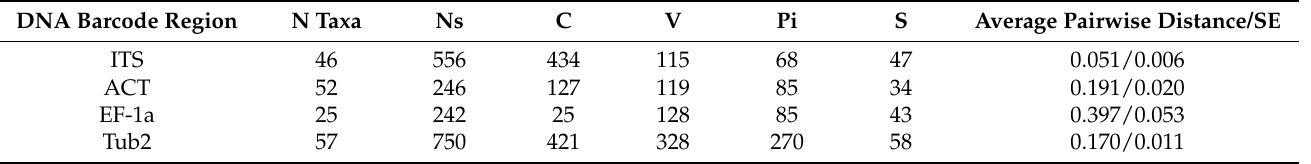
Table 5. Statistical parameters of genetic diversity within the genus Colletotrichum , calculated in MEGA11. Estimates of average evolutionary divergence over all sequence pairs from the number of base substitutions per site are shown. The standard error estimate(s) were obtained by a bootstrap procedure (500 replicates). The rate variation among sites was modelled with a gamma distribution (shape parameter = 1). All ambiguous positions were removed for each sequence pair (pairwise deletion